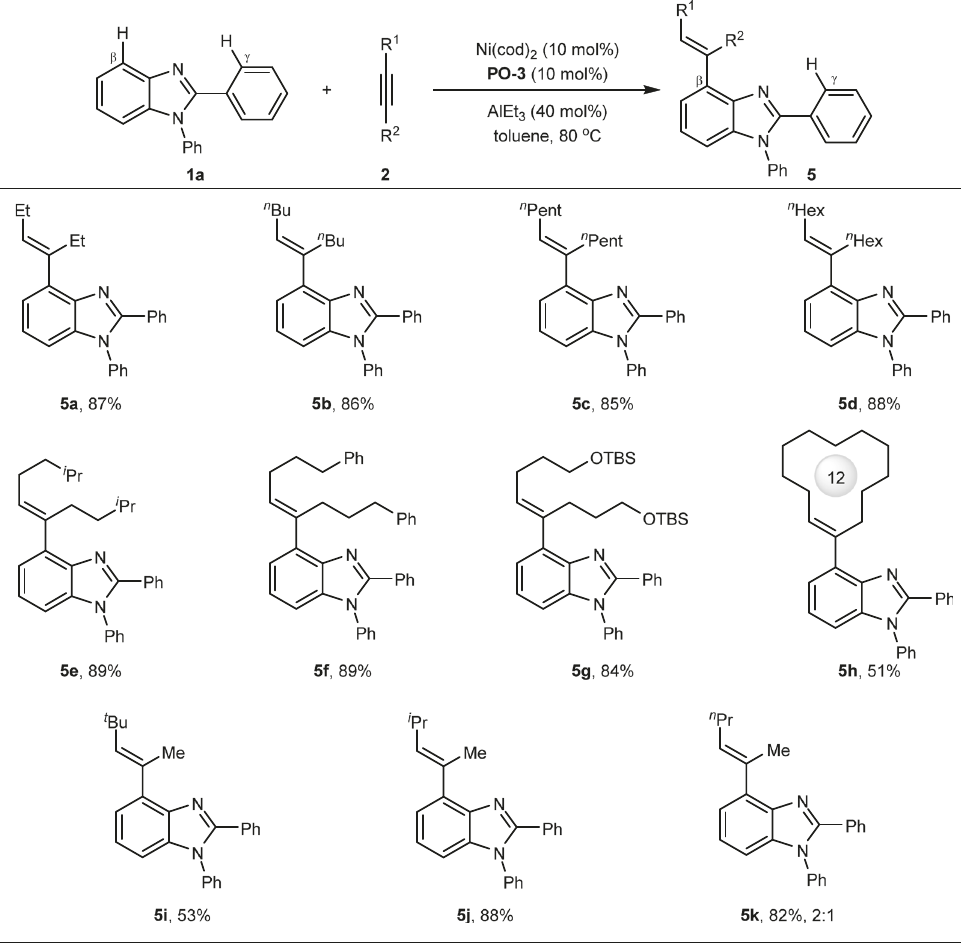
Fig. 4 Scope of alkynes. Reaction conditions: 1a (0.4 mmol), 2 (0.8 mmol), AlEt 3 (1 mol/L in hexane, 0.16 mmol), toluene (0.8 mL) under N 2 for 12 h. Yield of isolated products. Et = ethyl. n Bu = n -butyl. n Pent = n -pentyl. n Hex = n -hexyl. i Pr = isopropyl. TBS = tert -butyldimethylsilyl. t Bu = tert